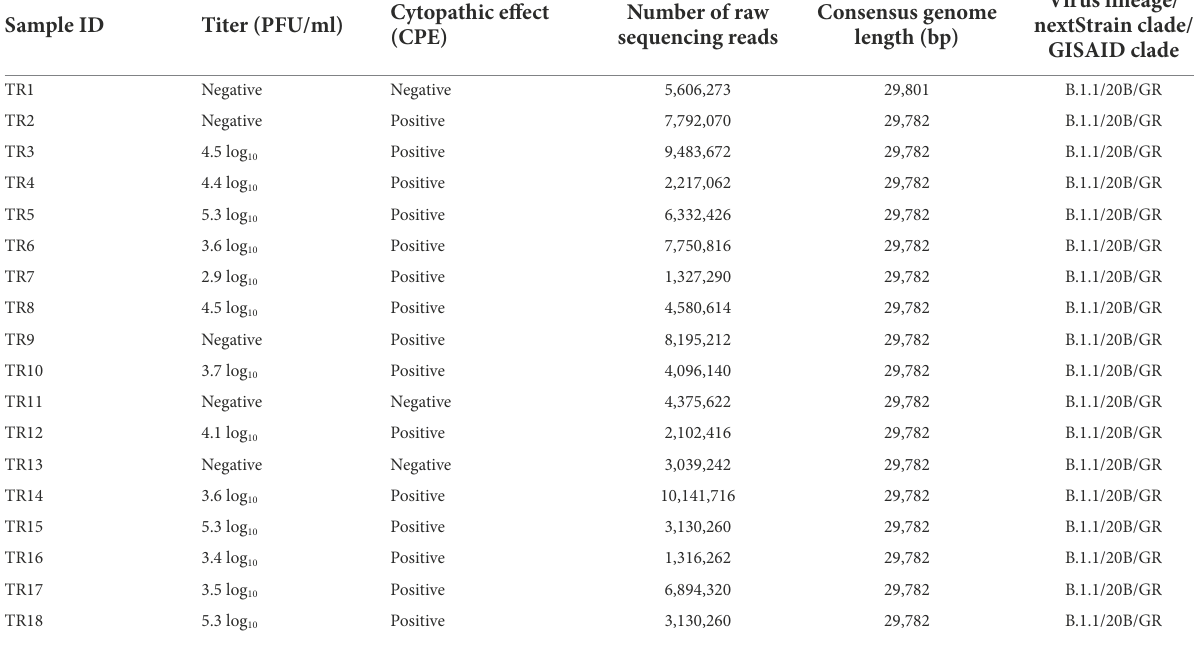
be categorized into seven discrete groups. Group I consisted of genomes from the three samples (TR16, TR17, and TR18) which